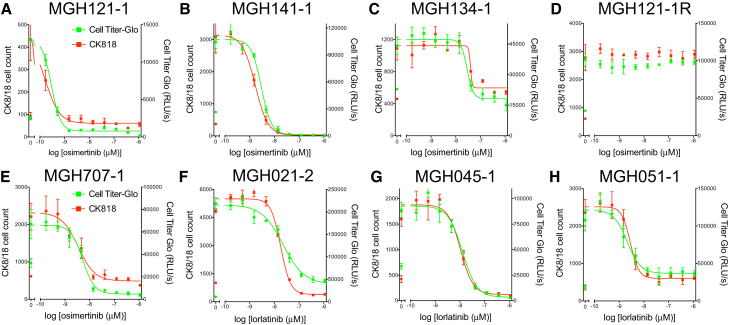
Comparison of Responses to EGFR and ALK Inhibitors Measured Using CK8/18-Positive Cell Count and CellTiter-Glo in EGFR-Mutant and ALK-Translocated Cancer Cells(A–H) Patient-derived EGFR-mutant (A–E) or ALK-translocated (F–H) lung cancer cells growing in 384-well plates in R10 or D10 media were treated with nine doses of the EGFR inhibitor osimertinib or the ALK inhibitor lorlatinib for 4–7 days. (A) MGH121-1. (B) MGH141-1. (C) MGH134-1. (D) MGH121-1R. (E) MGH707-1. (F) MGH021-2. (G) MGH045-1. (H) MGH051-1. (MGH121-1R cells were made resistant in vitro to the third-generation EGFR inhibitor WZ4002 by increasing its concentration over time.) Plates were either fixed and stained with Hoechst 33342 and the anti-CK8/18 antibody to determine the change in CK8/18-positive cells (red curves, left y-axes) or treated with CellTiter-Glo to determine the change in ATP concentration (green curves, right y-axes). Circles indicate CK8/18-positive cell number (red) or CellTiter-Glo measurement (green) at the day of treatment initiation. Nonlinear regression curves fit to the data points are shown, and data are represented as mean ± SD with n = 4 replicates and experiments performed twice.